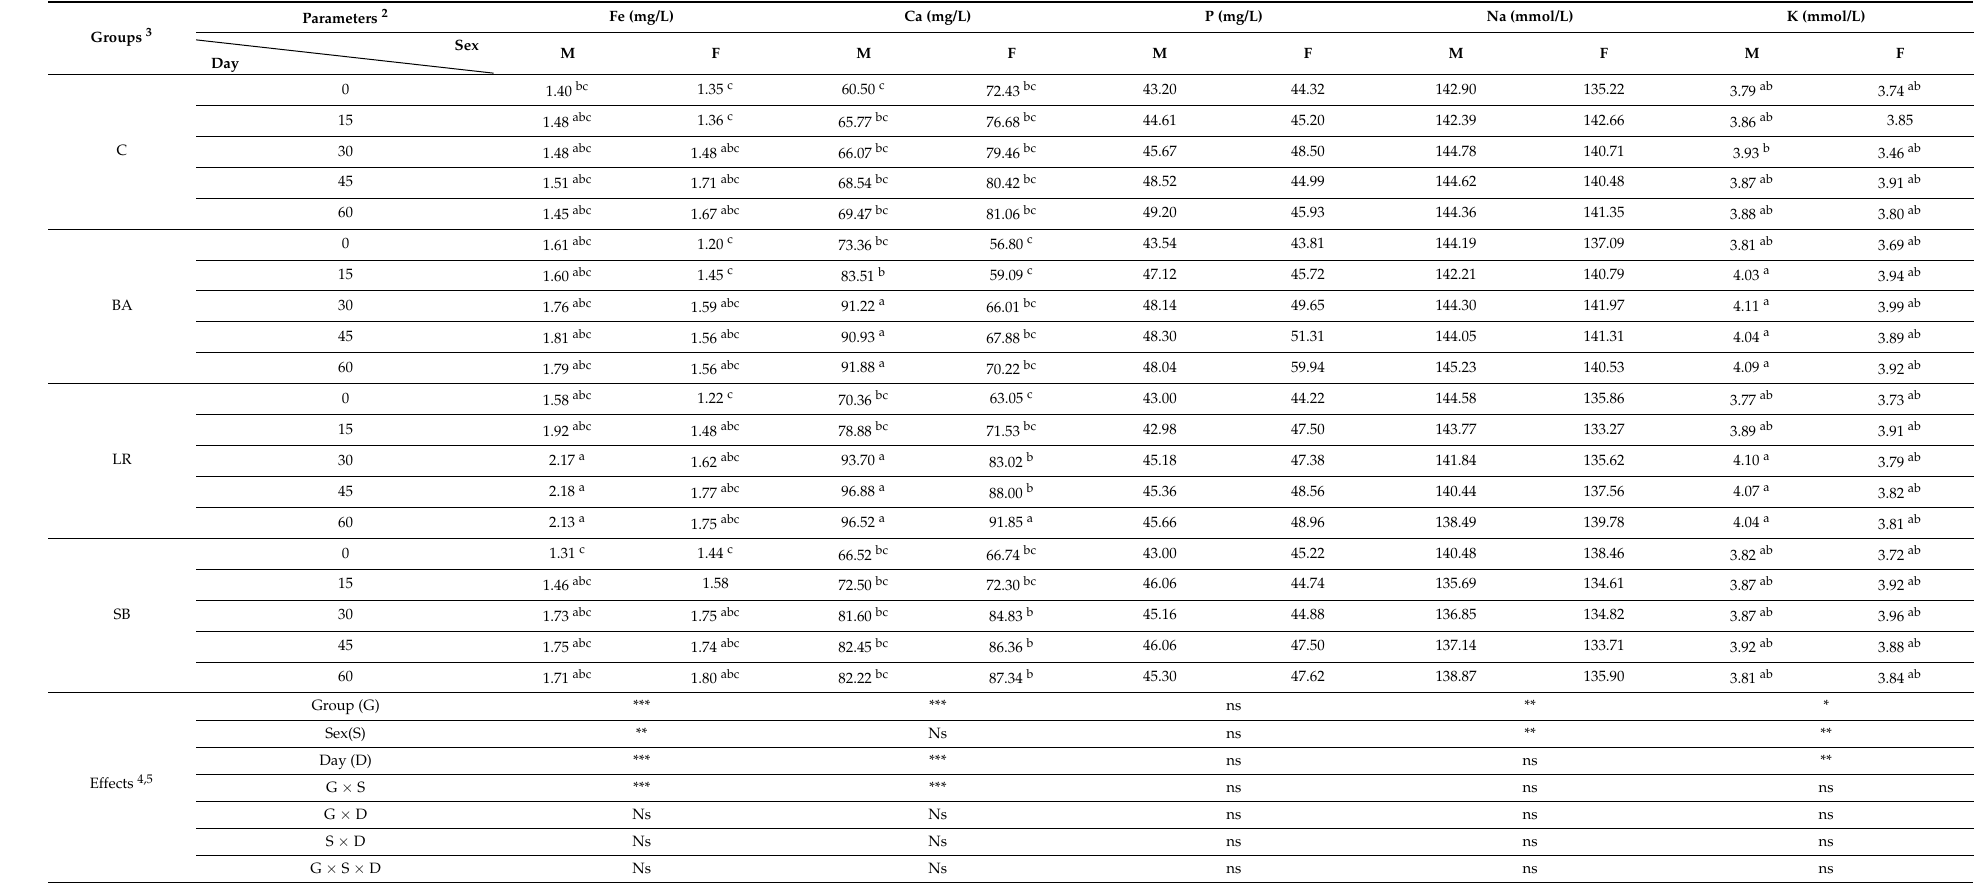
Table 2. Effects of dietary supplementation with probiotics on ionic parameters of healthy rabbits 1